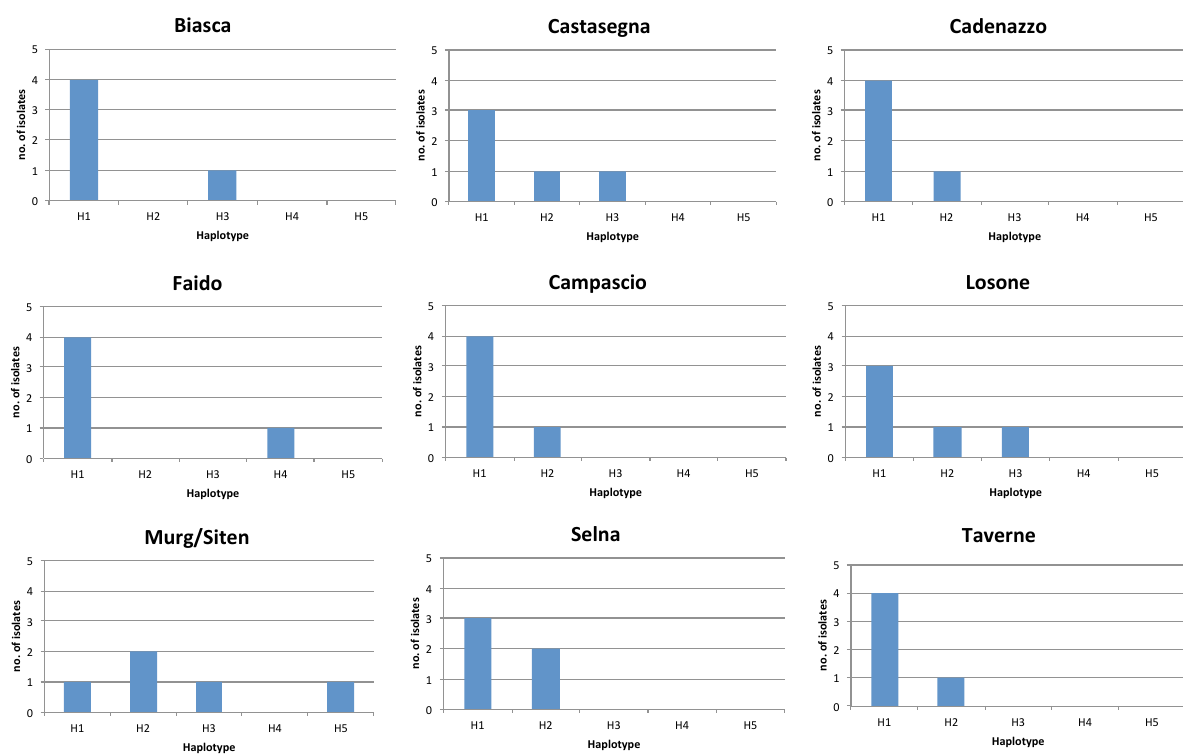
Figure 8. Frequencies of haplotypes obtained with the concatenated calmodulin and β-tubulin sequences at each sampling site. Haplotype H1 was the most frequent at all sampling sites except in